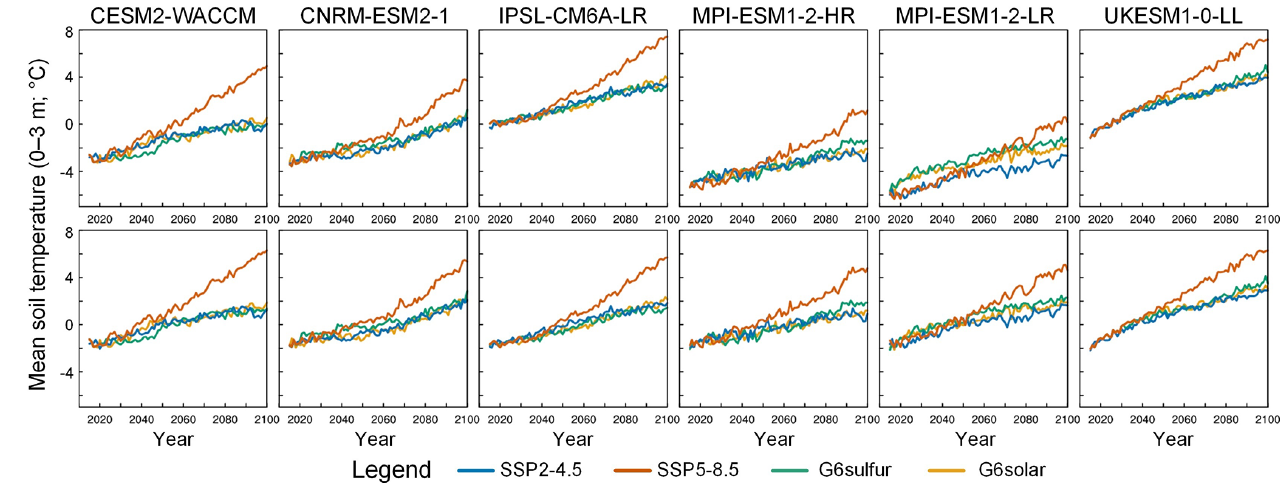
Figure 1. Bias correction of soil temperature (TSL). Mean annual soil temperature in the upper 3m of the circum-Arctic permafrost region before (top row) and after (bottom row) bias correction. The bias correction offsets for each ESM are shown in Table 2.